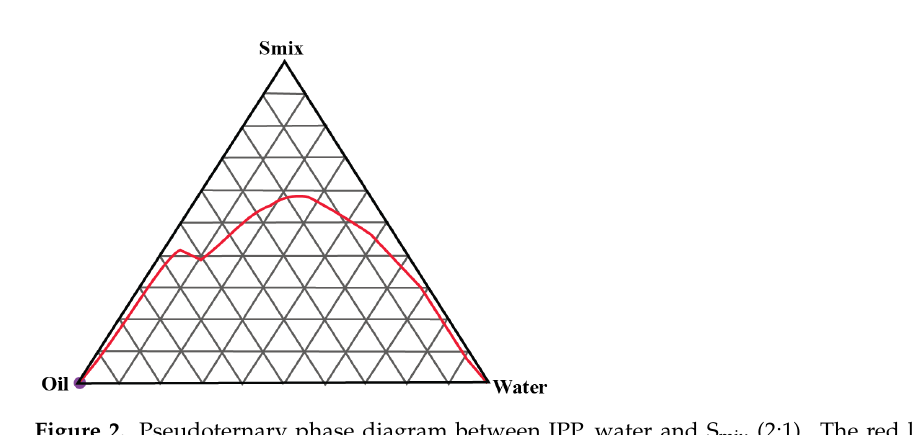
Figure 1. Pseudoternary phase diagram between IPP, water and S mix (1:1). The red line shows the boundary between the monophasic and biphasic region. The area above redline represents the monophasic region.